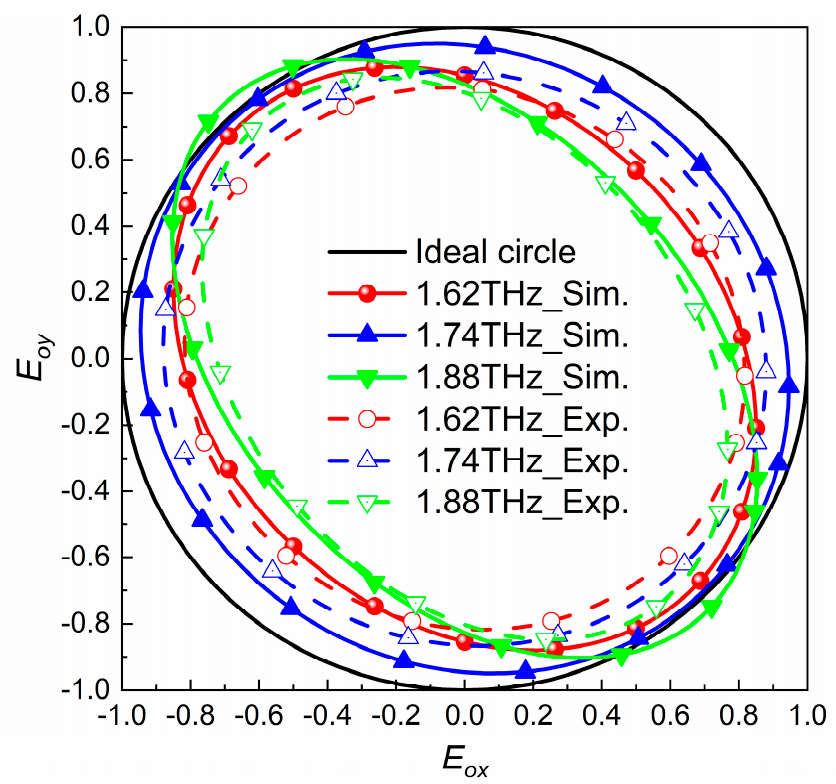
Figure 3. Circularly polarized wave simulation (dotted, solid lines) and experimental (dot–dashed lines)